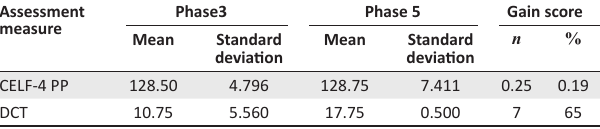
TABLE 3: Control group: Statistical analysis of assessment scores (Phases 3 and 5). Assessment measure